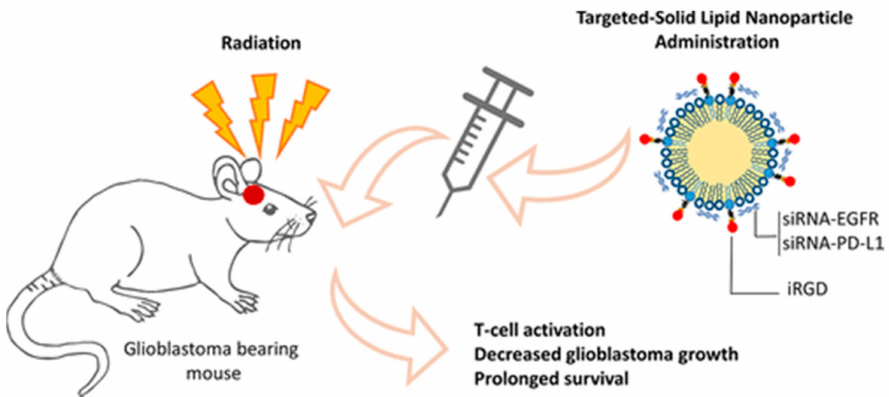
Figure 4. Schematic illustration of the brain tumor therapy. Reprinted with permission from Erel Akbaba et al. [72]. Copyright (2019) American Chemical